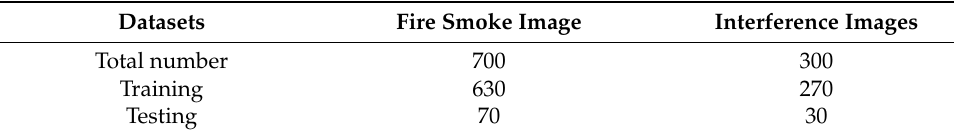
Table 1. The details of our datasets.